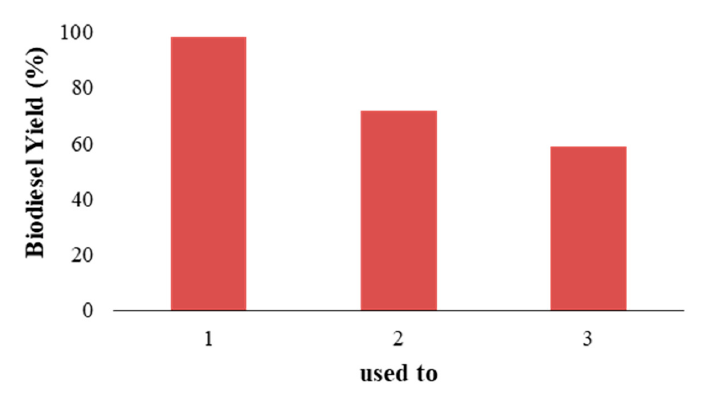
Figure 7. Biodiesel yield at several times the use of a catalyst.